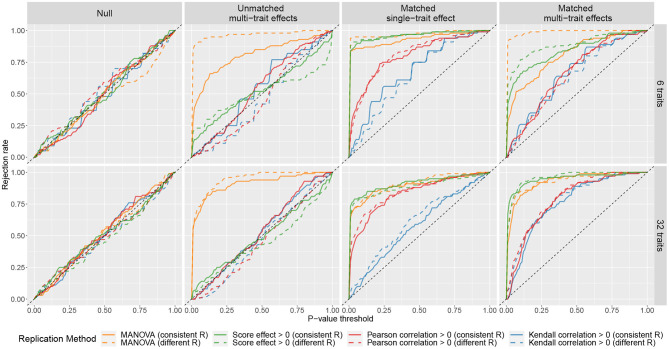
Rejection rates of four replication methods at different P-value thresholds under different simulated scenarios. For each scenario, 100 simulations were performed. In each simulation, a discovery sample and a replication sample were generated with one SNP and either 6 traits (the first row) or 32 traits (the second row). The k traits were simulated as y = βg + ϵ, where β = (β1, ..., βk) represents the cross-phenotype effects of the SNP on the k traits, and ϵ = (ϵ1, ..., ϵk) are residuals. Four matching scenarios between the cross-phenotype effects in discovery sample βdisc and those in replication sample βrep were simulated: (i) null, where βdisc = βrep = 0; (ii) unmatched multi-trait effects, where βdisc and βrep were independently drawn from a normal distribution; (iii) matched single-trait effect, where β1,disc was drawn from a normal distribution and β1,rep = β1,disc, while (β2,disc, ..., βk,disc) = (β2,rep, ..., βk,rep) = 0; and (iv) matched multi-trait effects, where βdisc was drawn from a normal distribution and βrep = βdisc. The covariance matrices of ϵ in discovery sample and replication sample can be either the same (marked as consistent R) or different (marked as different R). More details can be found in Supplementary Note.